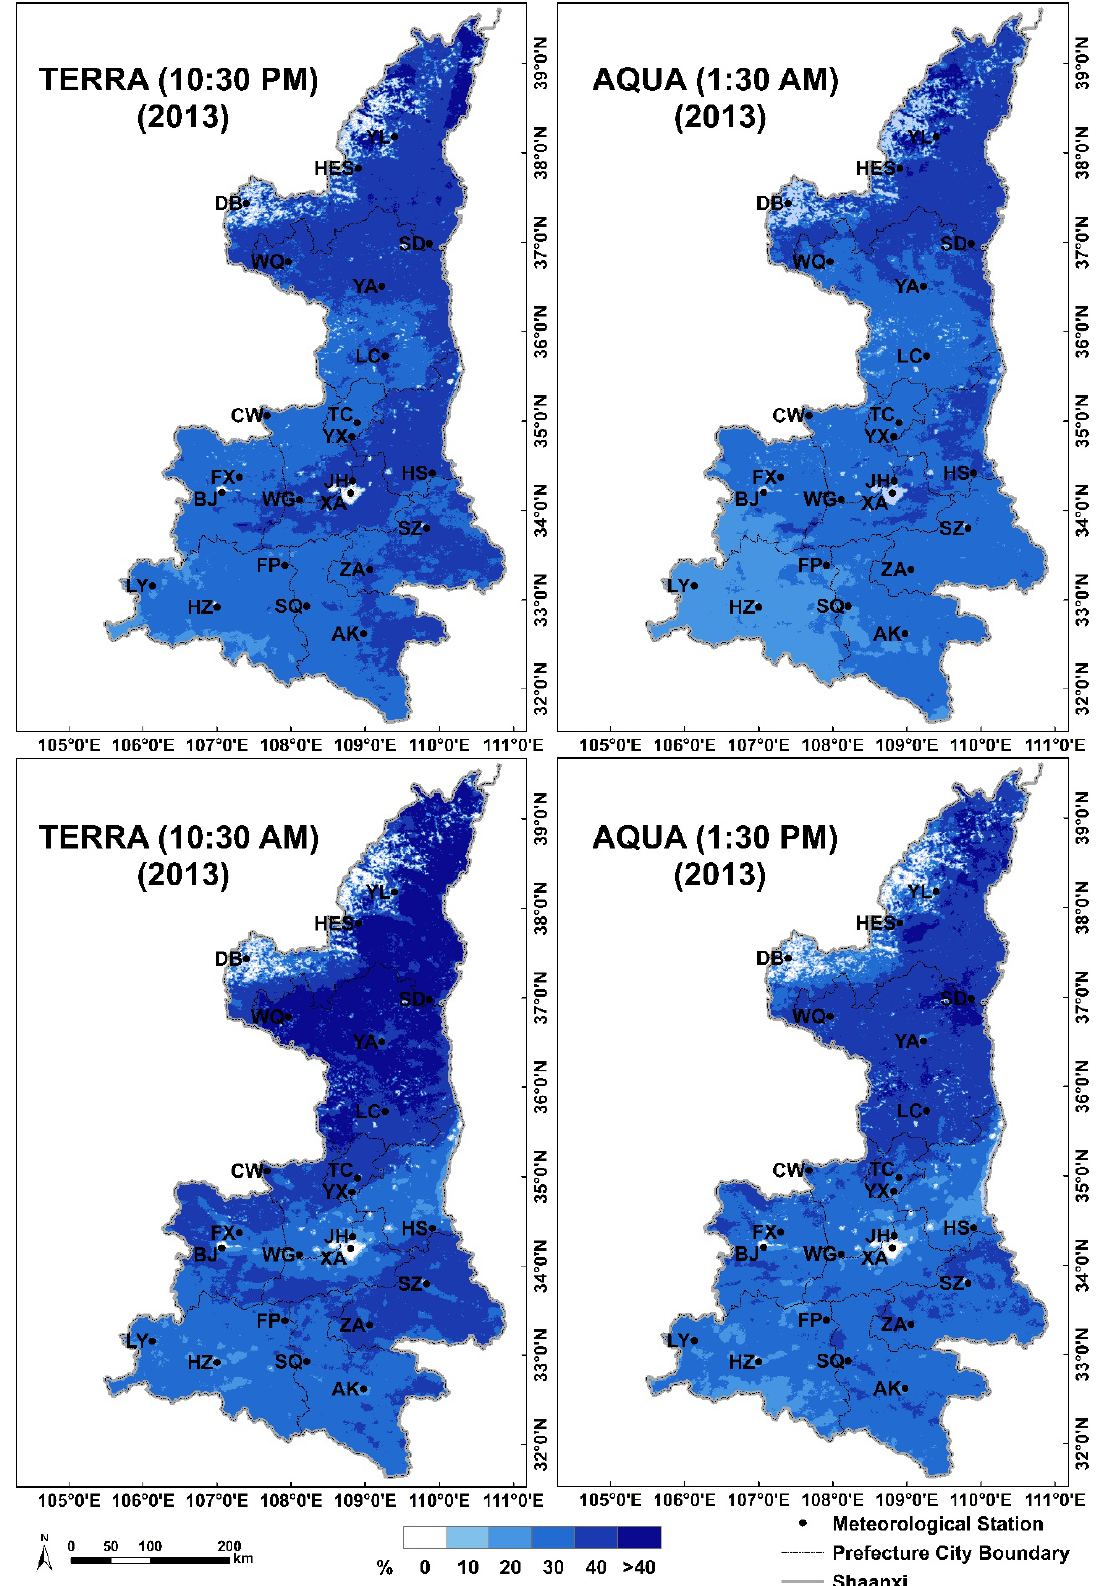
Figure 5. Percentages of available data for daily mean air temperature ( TA ) in 2013 based on daytime and nighttime TERRA and AQUA MODIS land surface temperatures